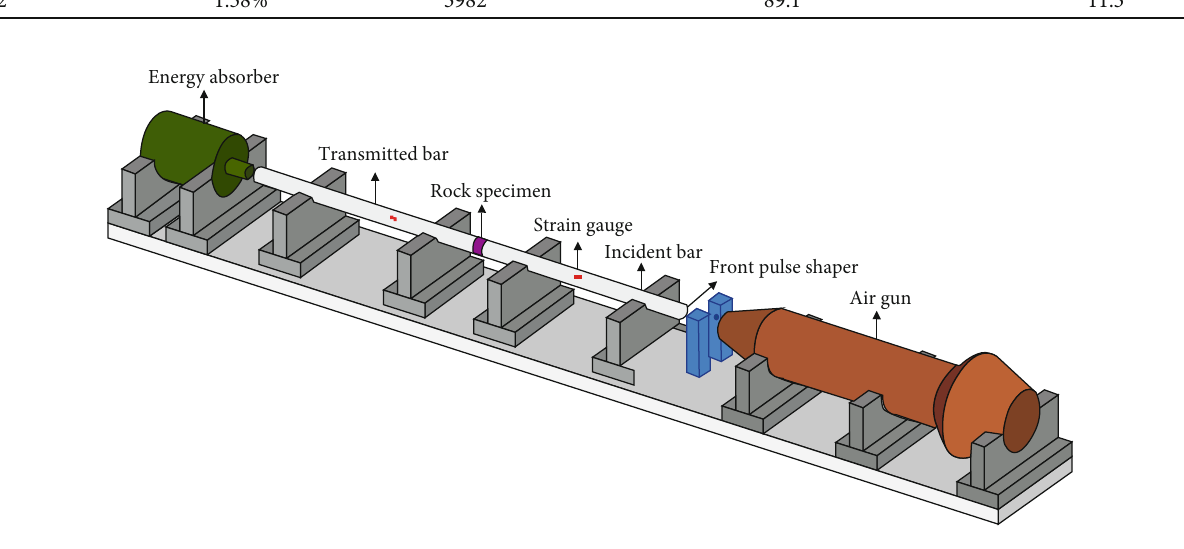
Figure 1: SHPB device.